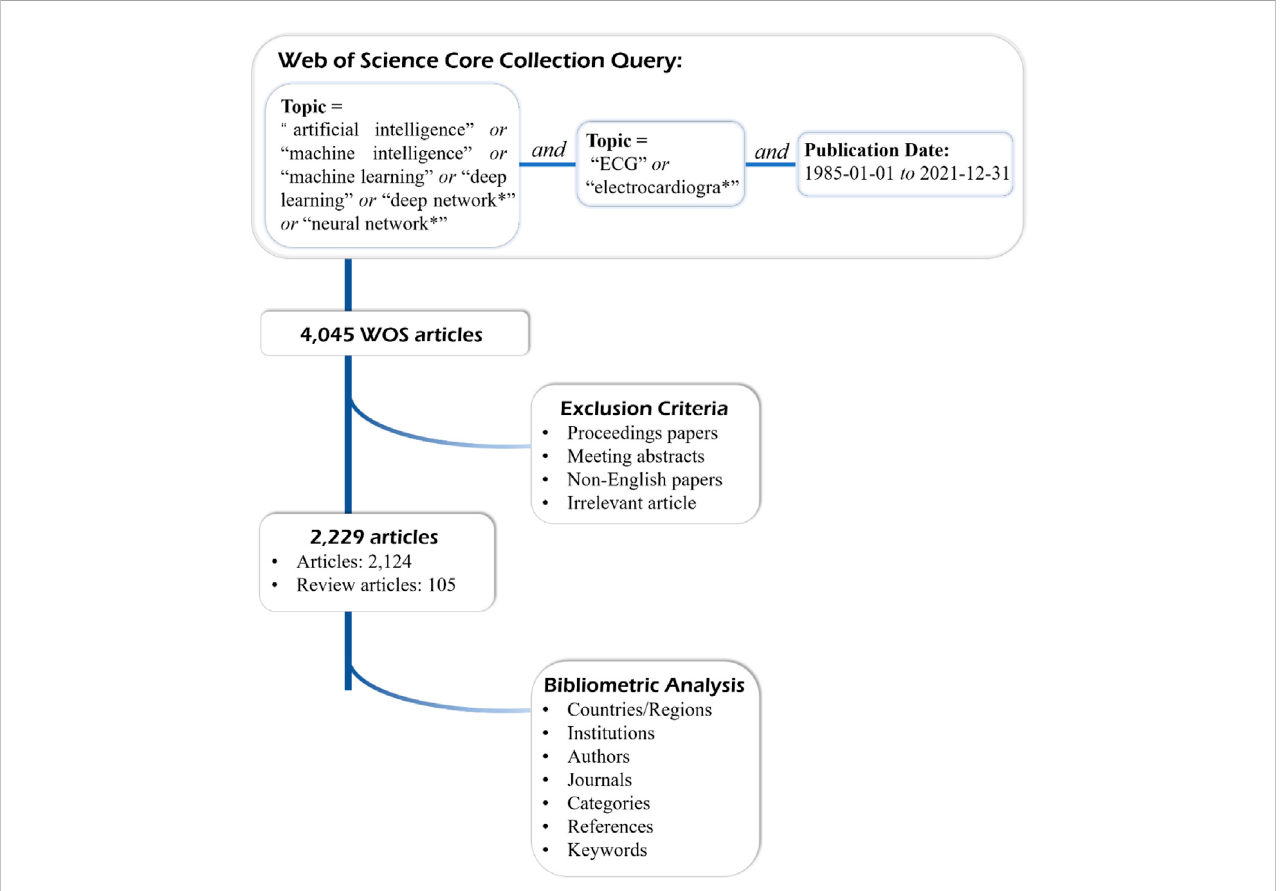
FIGURE 1 The fl owchart of searching strategy and research